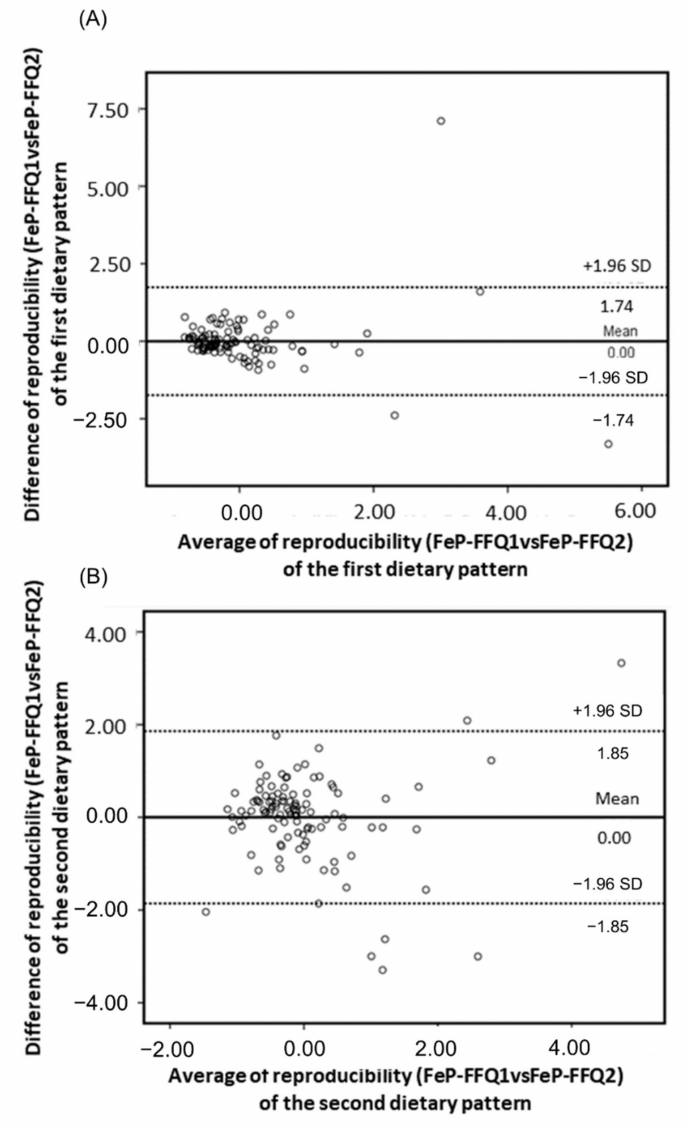
Figure 1. Bland–Altman plots for dietary patterns reproducibility between FeP-FFQ1 and FeP-FFQ2: ( A ) “healthy” pattern agreement, ( B ) “industrialized food and dairy” pattern agreement. The solid line represents the mean difference, and the dotted lines represent the agreement limits (SD ±